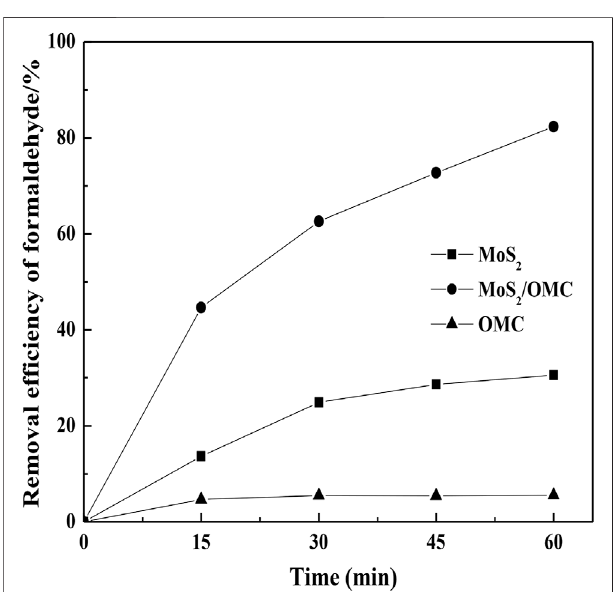
FIGURE 3 | Photocurrent spectroscopy of three photocatalysts materials (MoS 2 , OMC, and MoS 2 /OMC). FIGURE4 | Comparison of three photocatalystsmaterials (MoS 2 , OMC, and MoS 2 /OMC) for formaldehyde removal.